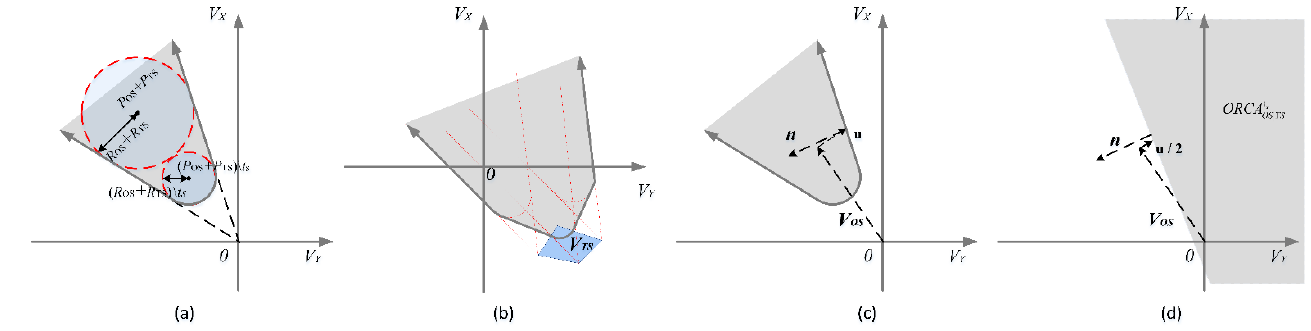
Figure 3. Calculate the optimal velocity by ORCA: ( a ) When TS is stationary, the collision velocity is calculated; ( b ) When TS is moving, the collision velocity is calculated; ( c ) The geometric meaning of the vector u and n are expressed; ( d ) The geometric meaning of the optimal velocity is expressed.